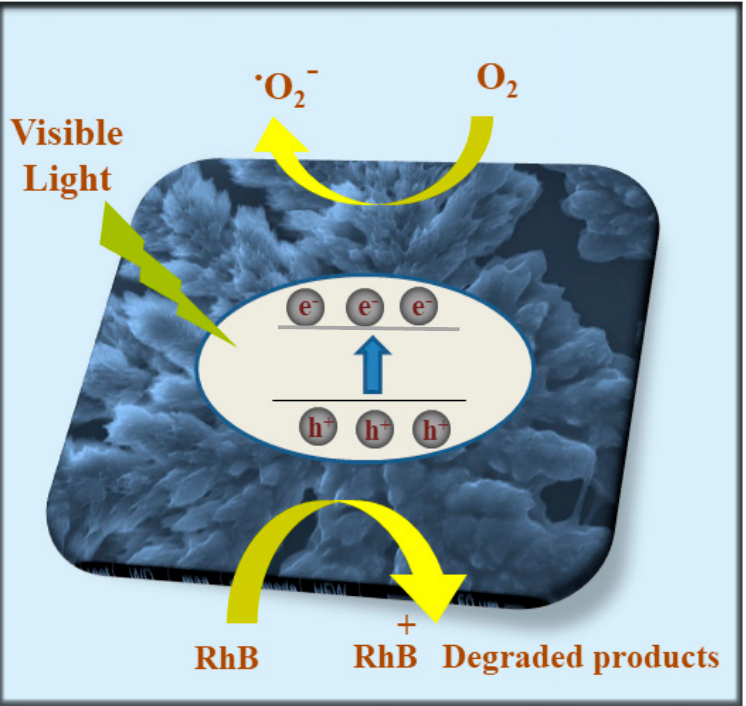
Figure 7. Schematic representation of self-assembled PPIX and L -/ D -arginine photocatalyst materials in RhB dye degradation.